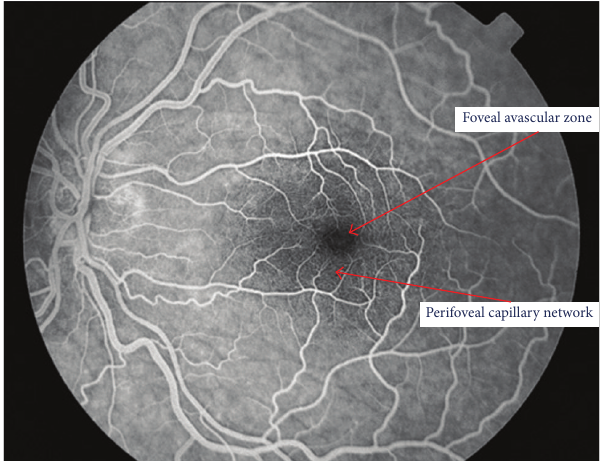
Figure 6: Normal fluorescein angiography showing the avascular foveal area and the perifoveal capillary